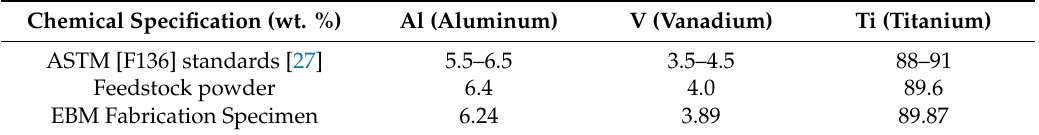
Figure 12. Micro-CT scan of dode thick cube for checking internal defects. The histological study on post-operative specimens obtained from the goat mandibles revealed new bone formation with osteoblast cell attachment and proliferation on the EBM reconstruction plates and the commercial plate. Mild inflammatory reaction and mixed micrometer particles of titanium were observed in the hard tissue and soft tissue specimens obtained from animals in all the three groups (Figure 13a). However, no clinically discernible foreign-body reaction took place in any of these animals during the entire post-operative study period. The inflammatory response in the tissues could also be attributed to the physiological healing mechanism of the long-term study. Nevertheless, newly formed cancellous bone islands with osteocytes and neovascularization interspersed with connecting tissue was seen at the defect site adjoining the reconstruction plates in